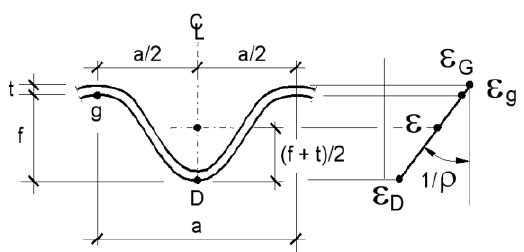
Figure 3: Corrugated plate cross section and distribution of unit